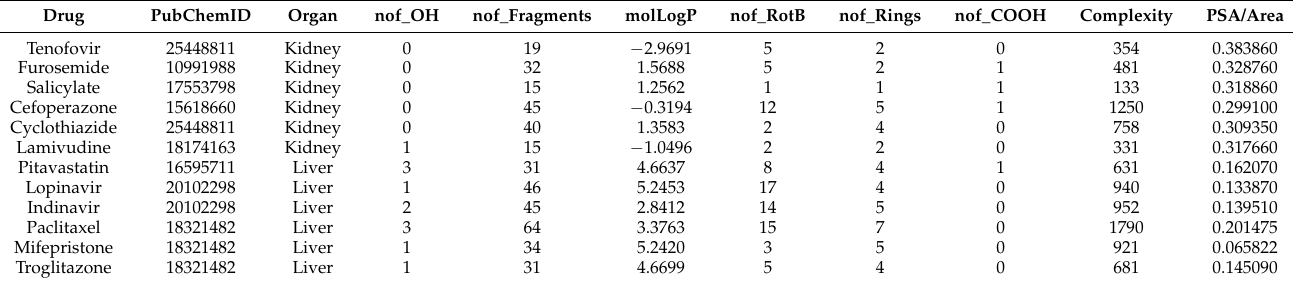
Table 2. Eight molecular properties for 12 drugs highlighted in the FreeViz diagram (Figure 3).